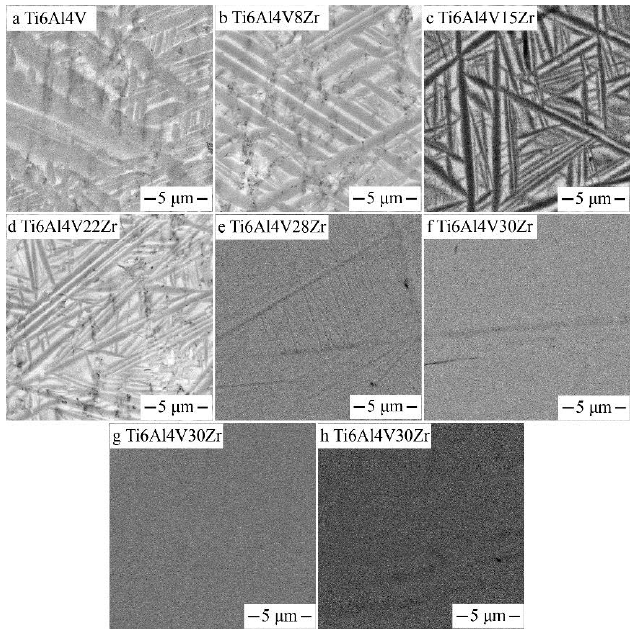
Figure 4. SEM, backscattered electron images of beta annealed Ti6Al4VxZr alloys taken from the Ti6Al4V – Ti6Al4V45Zr diffusion multiple.